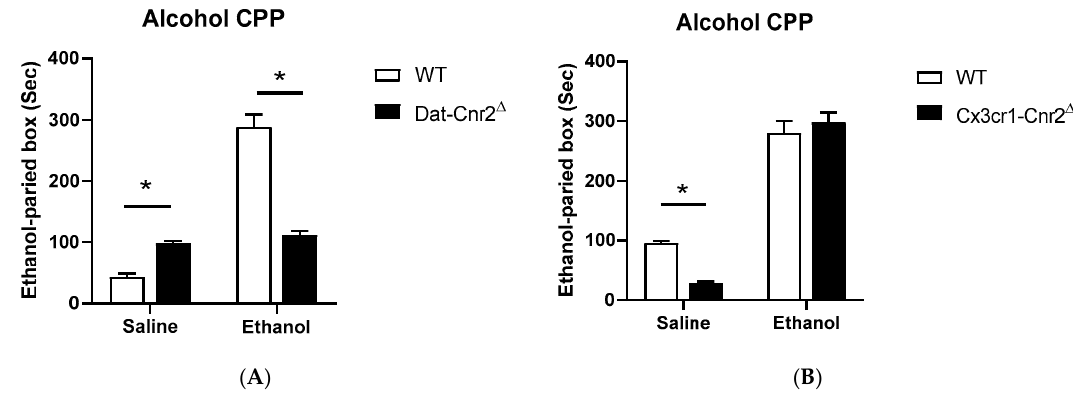
Figure 7. CB2R modulation of alcohol preference in Alcohol 8%-induced conditioned place preference in WT and Cx3cr1-Cnr2 Δ mice, but not in DAT-Cnr2 Δ mice. ( A ) WT and DAT-Cnr2 Δ mice; ( B ) WT and Cx3cr1-Cnr2 Δ mice. Asterisks represent p < 0.05.